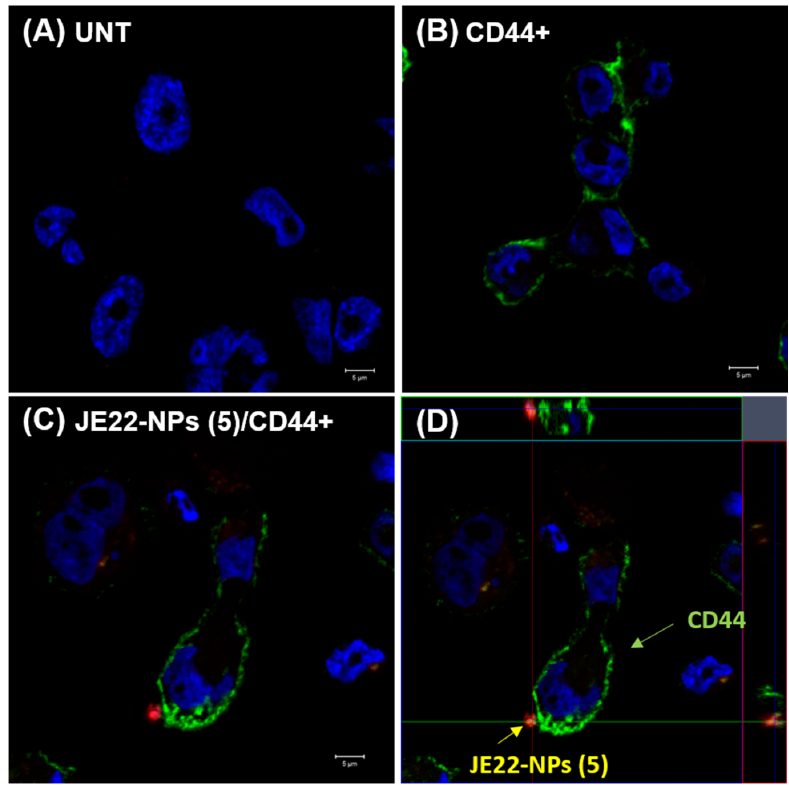
Figure 6. Confocal microscopy analysis of MDA-MB-231 (CD44+) cells treated with JE22-NPs ( 5 ). CD44-labeled cells treated with JE22-NPs ( 5 ) fluorescently labeled with Cy5 were analyzed ( C ) (Scale bar: 5 μ m). The cells were incubated for 30 min with 1000 NPs/cell. Untreated cells ( A ) and cells labeled with anti-CD44-FITC ( B ) were used as controls (Scale bar: 5 μ m). Images with an increase of 63× show a composition of the three channels used: blue, DAPI for the nucleus; green, FITC for anti-human CD44; and red, APC for JE22-NPs ( 5 ). ( D ) Confocal microscopy orthogonal (xy, xz, and yz) view representing the planes of intersection at the position of green cross line. The maximum intensity projection of the z-stack is shown blue for nuclei (DAPI), green for anti-human CD44 (FITC), and red for JE22-NPs ( 5 ) (APC).